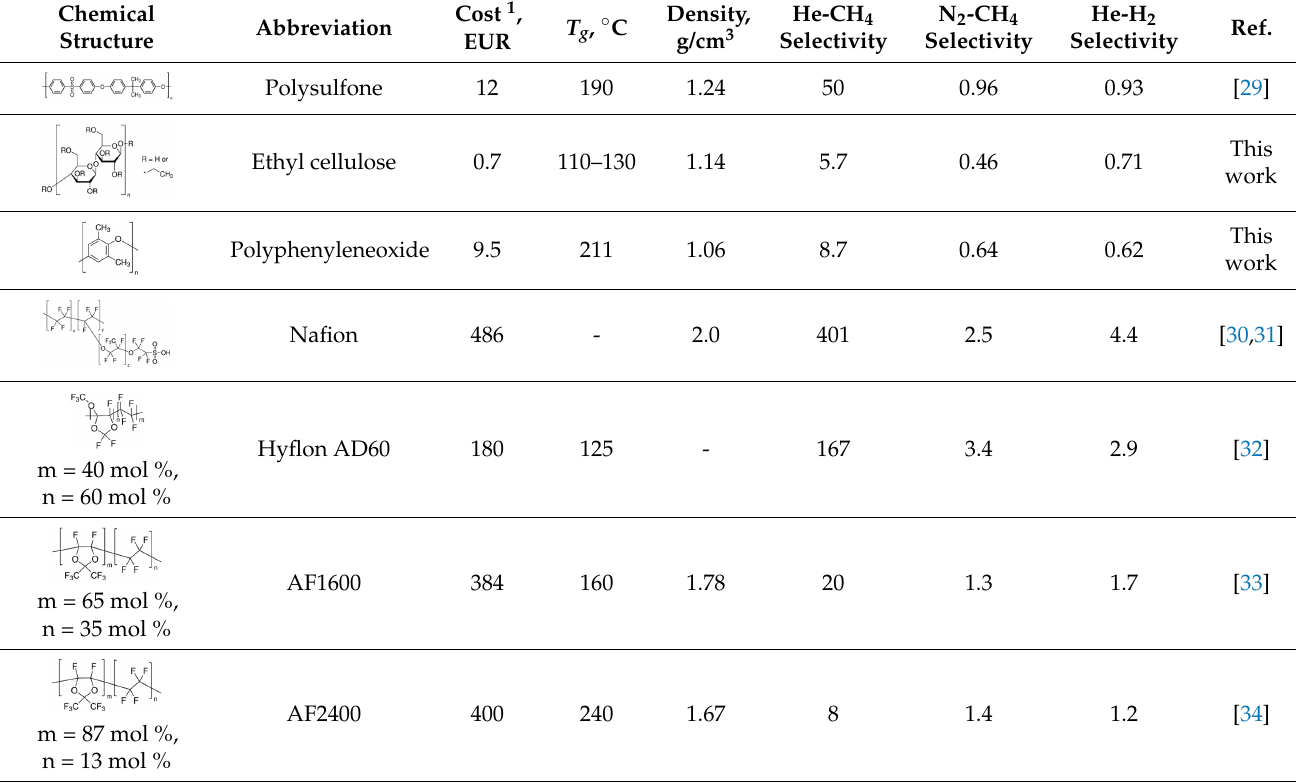
Table 1. Physicochemical properties and cost of some commercial fluorinated and non ‐ fluorinated polymers. Chemical Structure Abbreviation Cost 1 , EUR T g , °C Density, g/cm 3 He ‐ CH 4 Se ‐ lectivity